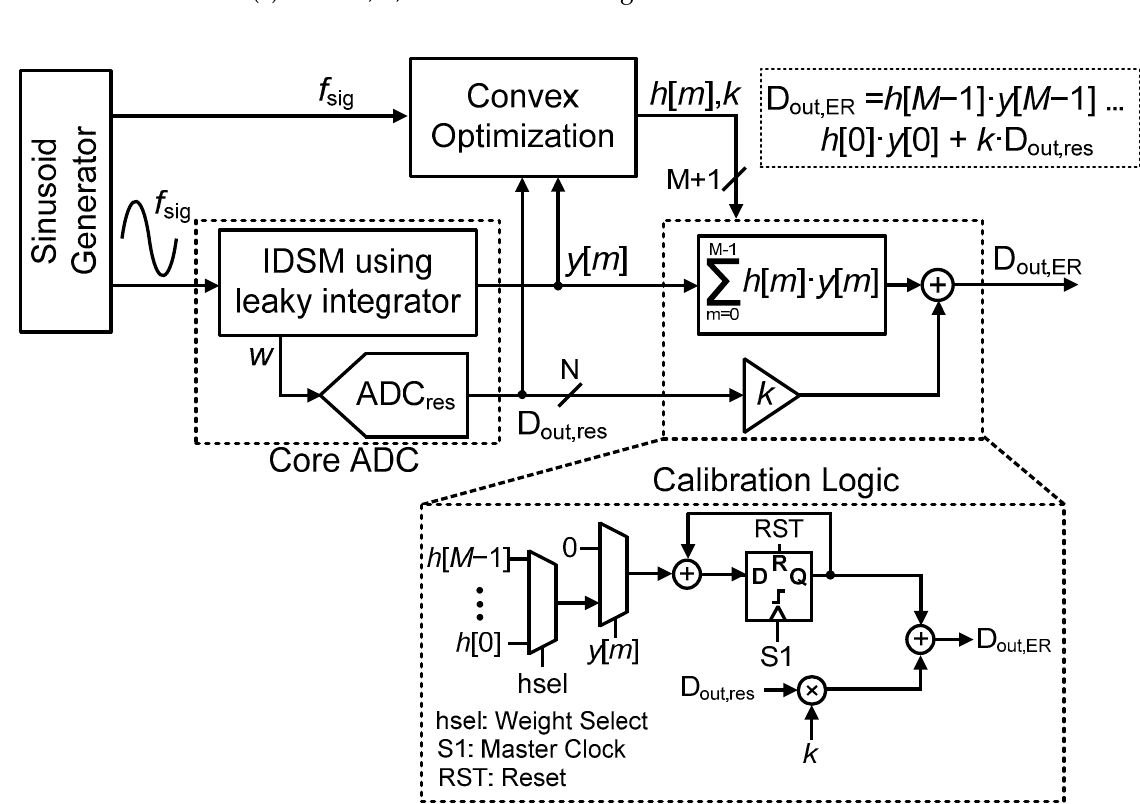
Figure 4. The setup for finding the optimal digital filter parameters.